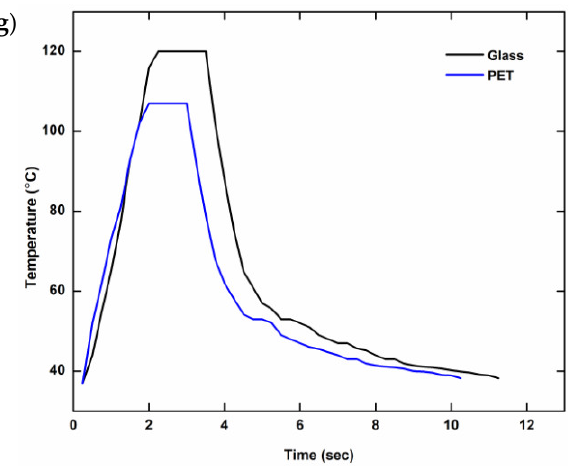
Figure 4. Characterization of printed RTDs. ( a , b ) Schematic illustration ( a ) and photograph ( b ) of the characterization setup for the temperature sensing; ( c ) resistance change with temperature variation; ( d ) normalized resistance change with temperature variation; ( e ) hysteresis graph of the sample (normalized data), printed on the glass substrate; ( f ) repeatability of the sample, printed on the glass substrate; and ( g ) response and recovery time, printed on both substrates. Table 2. Performance characterization of the printed RTDs on rigid and flexible substrates.